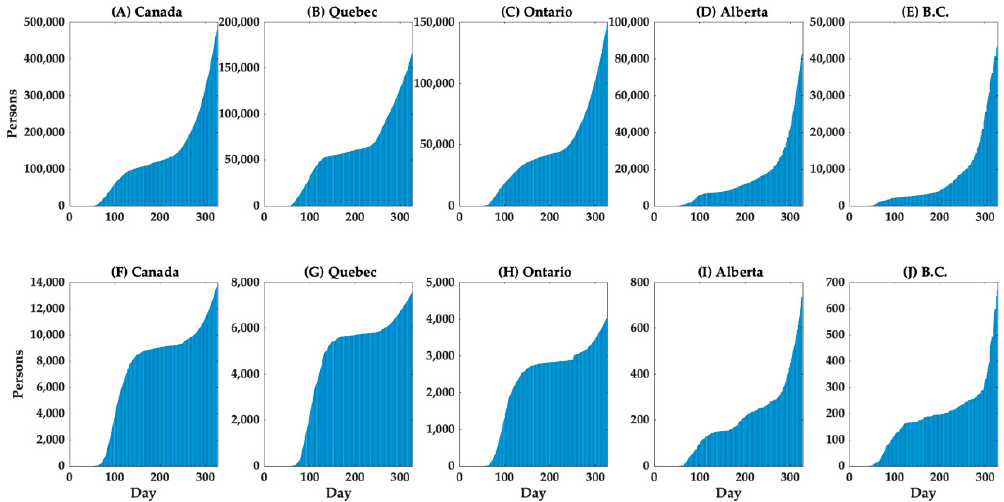
Figure 1. Temporal distribution of cases (top row) and deaths by area (bottom row), 1 February–15 December 2020. Cumulative cases in ( A ) Canada (total), ( B ) Quebec, ( C ) Ontario, ( D ) Alberta, and ( E ) British Columbia (B.C.), and cumulative deaths in ( F ) Canada (total), ( G ) Quebec, ( H ) Ontario, ( I ) Alberta, and ( J ) British Columbia (B.C.) are shown.